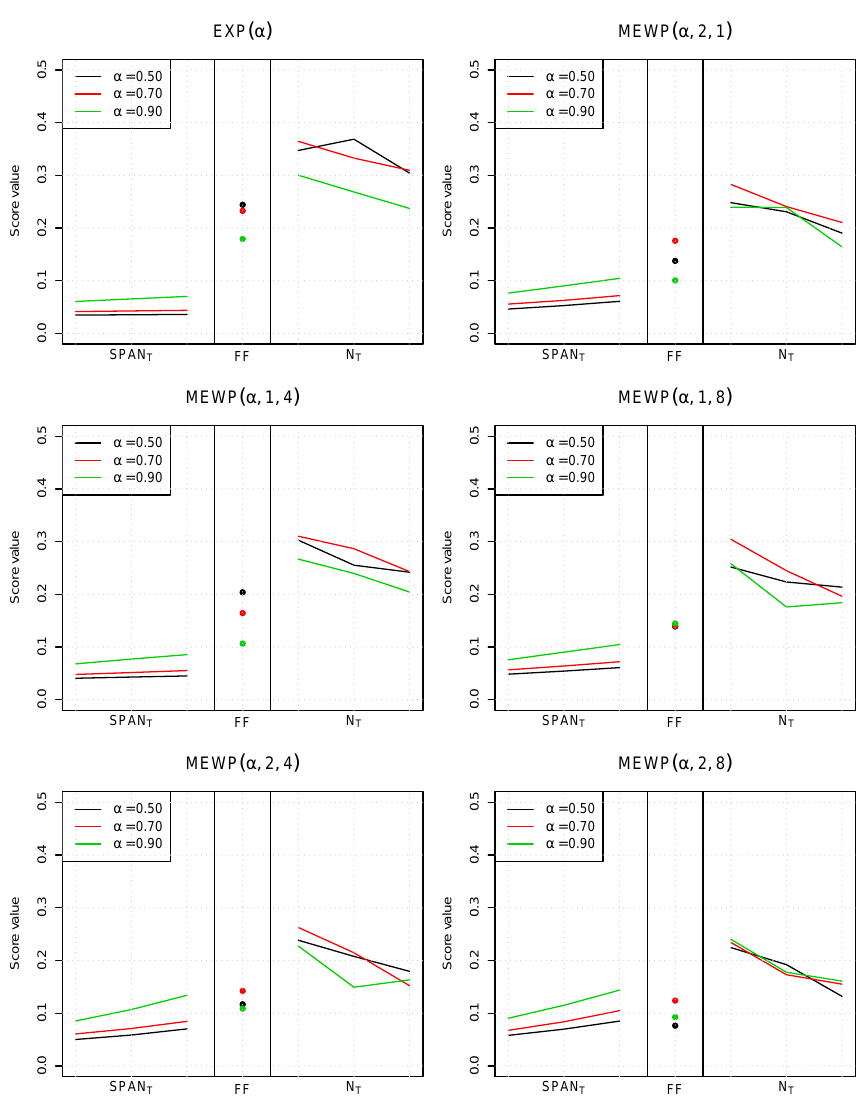
Figure 5. Scores of evaluation for MEWP models, for α = 0 . 5, 0 . 7 and 0 . 9. Better scores have values closer to 0. Scores of SPAN T , for T = 20 − , 100 − and 1000-year return periods, are the mean scores of Eq. (9), while scores of FF and N T , T = 5 , 10 and 20 years, are based on the density areas (Eq.